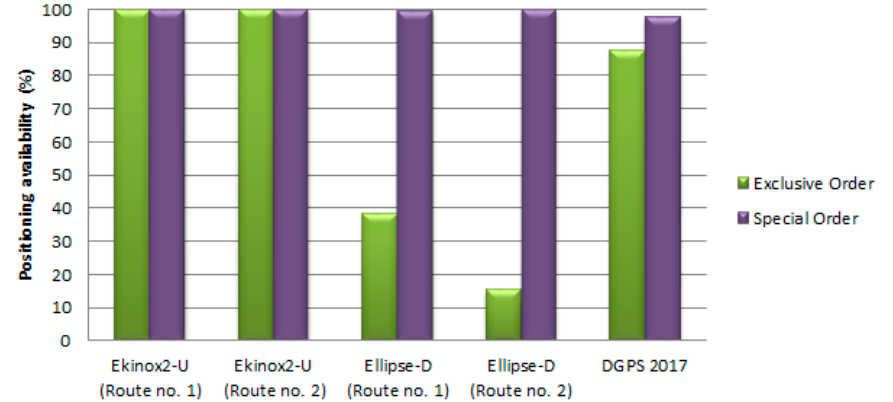
Figure 12. The availability factor values determined for the GNSS/INS systems in the context of minimum positioning requirements, set for the two most stringent IHO orders.